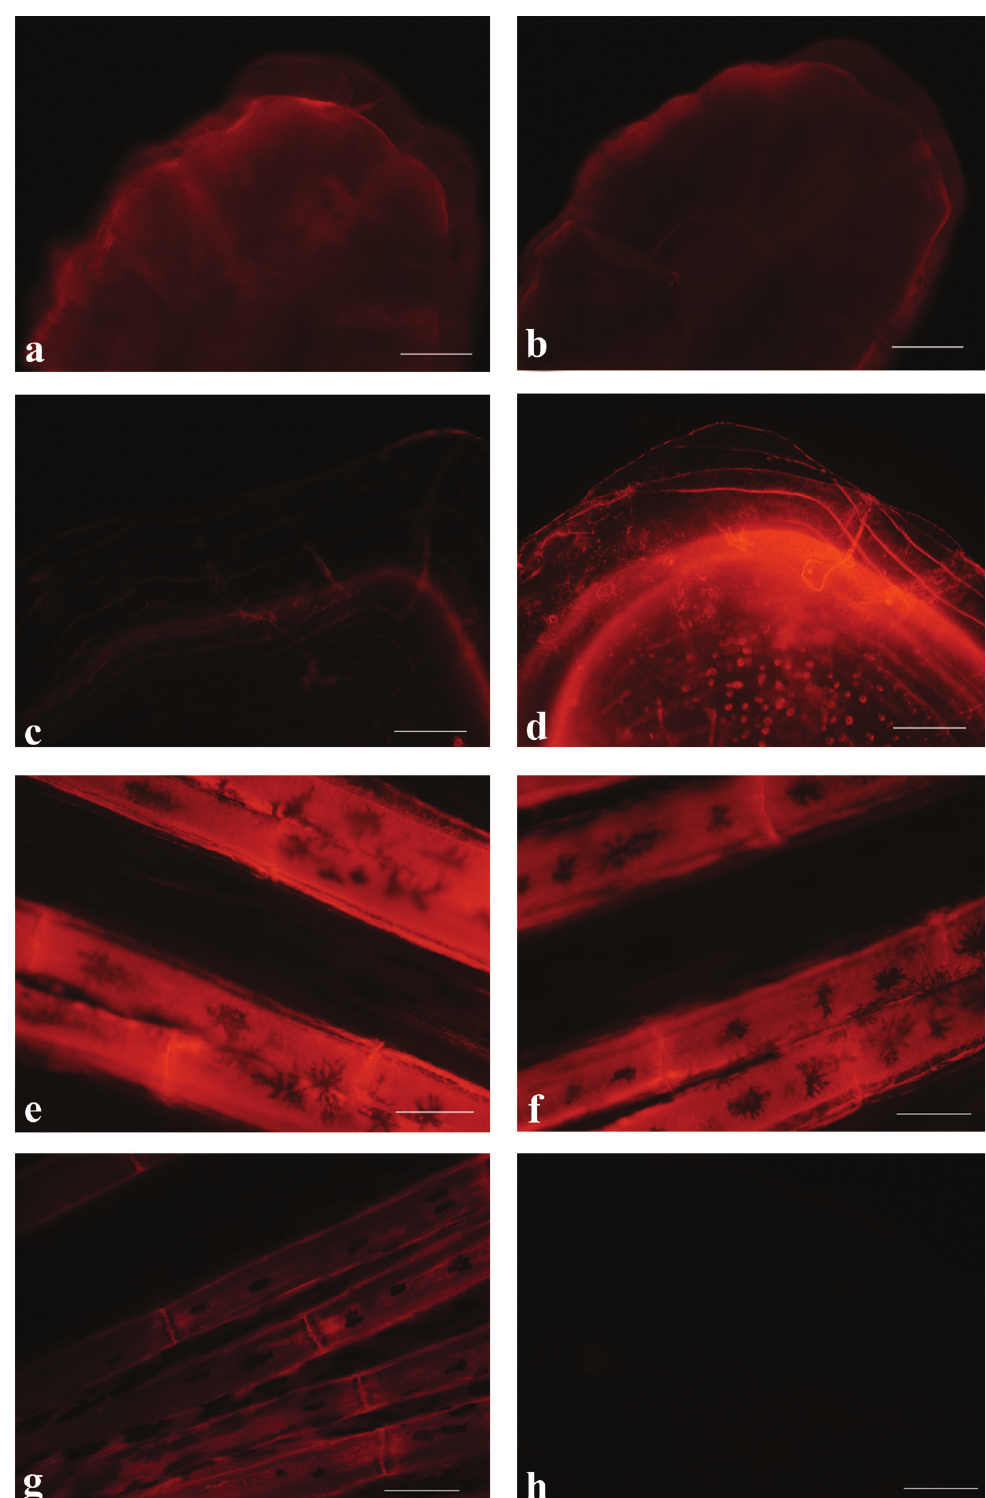
Fig. 2. After 73 days post-treatment, clear marks were observed for both marking procedures, in otoliths (Figs. 2a, b), scales (Figs. 2c, d) and caudal fin rays (Figs. 2e, f). The intensity of the signal in scales was higher in fish marked with OI+ARS (Fig. 2d). After 385 days, only marks in caudal fin rays were observed in fish treated with OI+ARS (Fig 2g). All control fish structures and, otoliths and scales for 385 days post- immersion showed no marks under fluorescence microscope (Fig. 2h). a, c, e: ARS treatment; b, d, f, g: OI+ARS treatment. Scale bar = 200